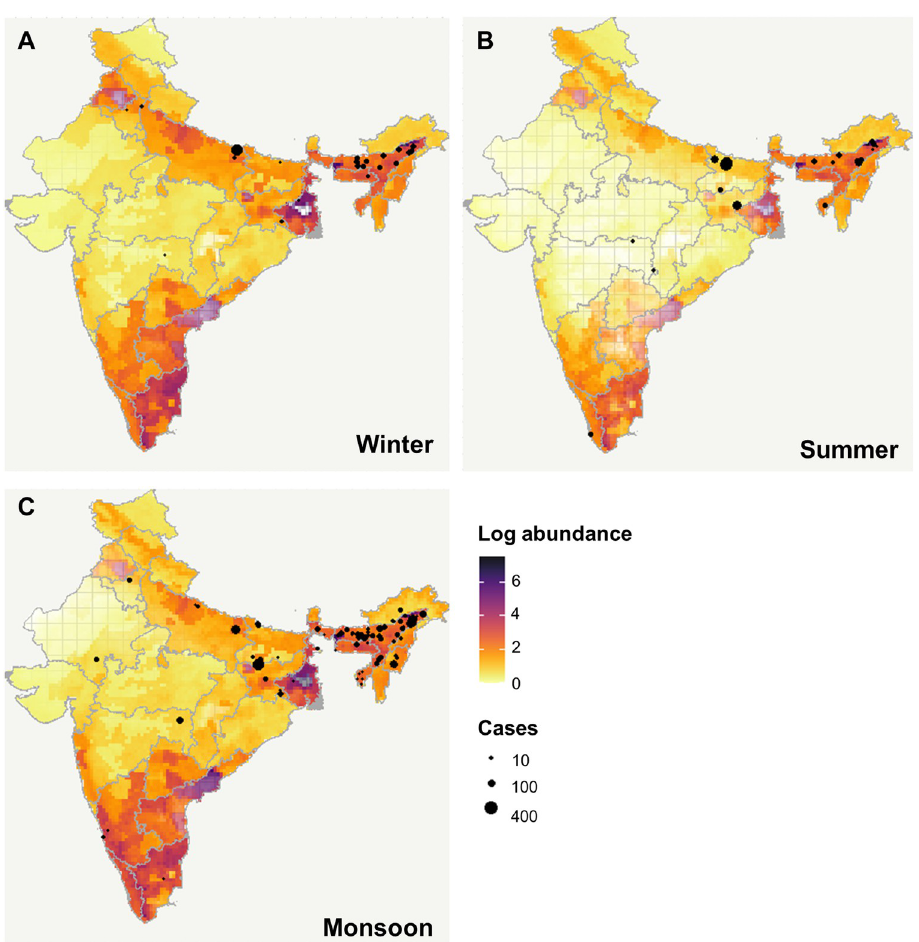
Fig 3. Predicted seasonal abundance of C . tritaeniorhynchus across India for the period 1990–2012. Average vector abundance (logscale) for the (A) winter (October to February), (B) summer (March to May) and (C) monsoon (June to September) seasons. The figure legend is scaled from 0 to 7 logscale, with light yellow colours signifying low vector abundance and dark purple emphasising high abundance. Uncertainty in predictions was estimated from standard deviation (range 0–2 SD) and is represented in the maps by transparency, (high uncertainty is more transparent). The black circles represent the location and magnitude (i.e., number of cases) for JE human outbreaks per season during the period 2009–2015 across India [68]. Source of base layer https://gadm.org.